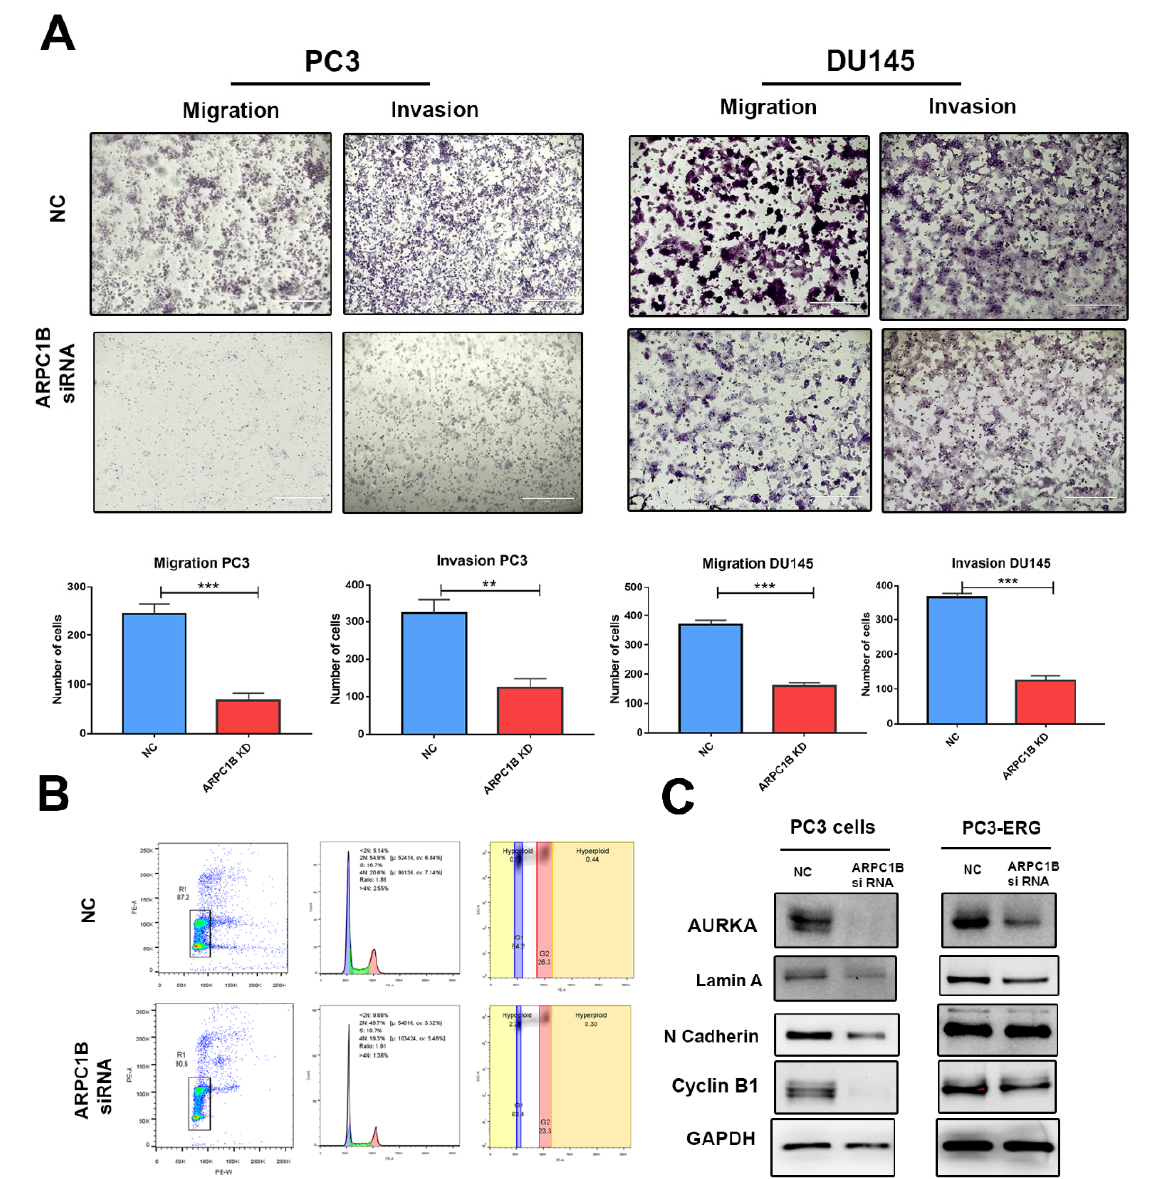
Figure 6. ARPC1 knockdown attenuates PCa cell migration and invasion. ( A ) Migration and invasion assay for PC3 and DU145 cell lines after 48 h of ARPC1B knockdown. *** p < 0.001, ** p < 0.01. Scale bar 400 µ M. ( B ) Cell cycle analysis using PI staining. Data analyzed and presented using FlowJo. ( C ) Western blot analysis of AURKA, Lamin A, N-Cadherin, Cyclin B1 in PC3, and PC3-ERG cell transfected with either ARPC1B, siRNA, or control scramble siRNA as the negative control. GAPDH used as loading